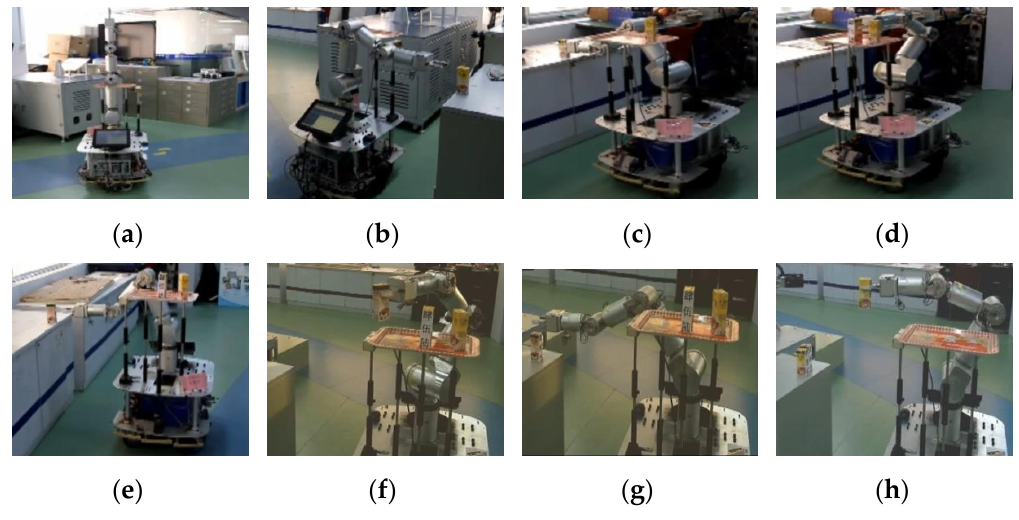
Figure 9. The execution process with the SBOP planner in the delivery domain. Table 2. Planners’ performance in scenario “collect and deliver drink boxes to a counter”. Planner